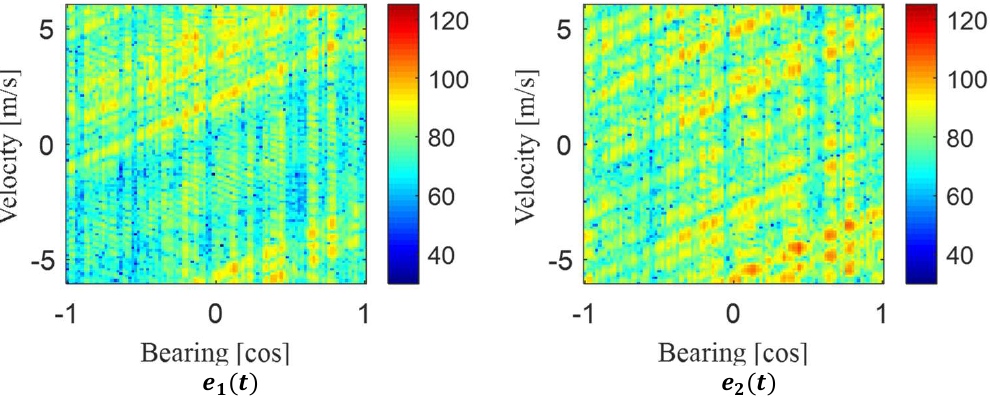
Figure 7. Reverberation zones for sub−waveform 𝑒 (cid:2869) ( left ) and 𝑒 (cid:2870) ( right ) of the CPTFM wave- form.